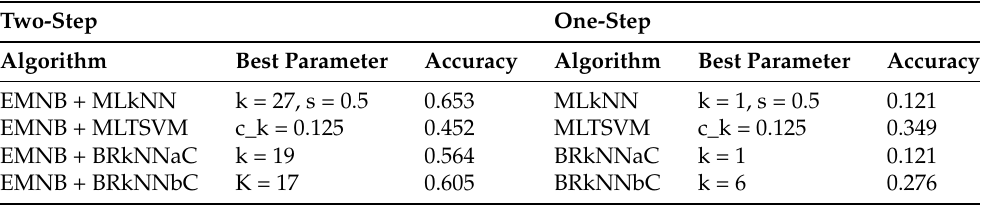
Table 3. Comparison of the performance of two- and one-step